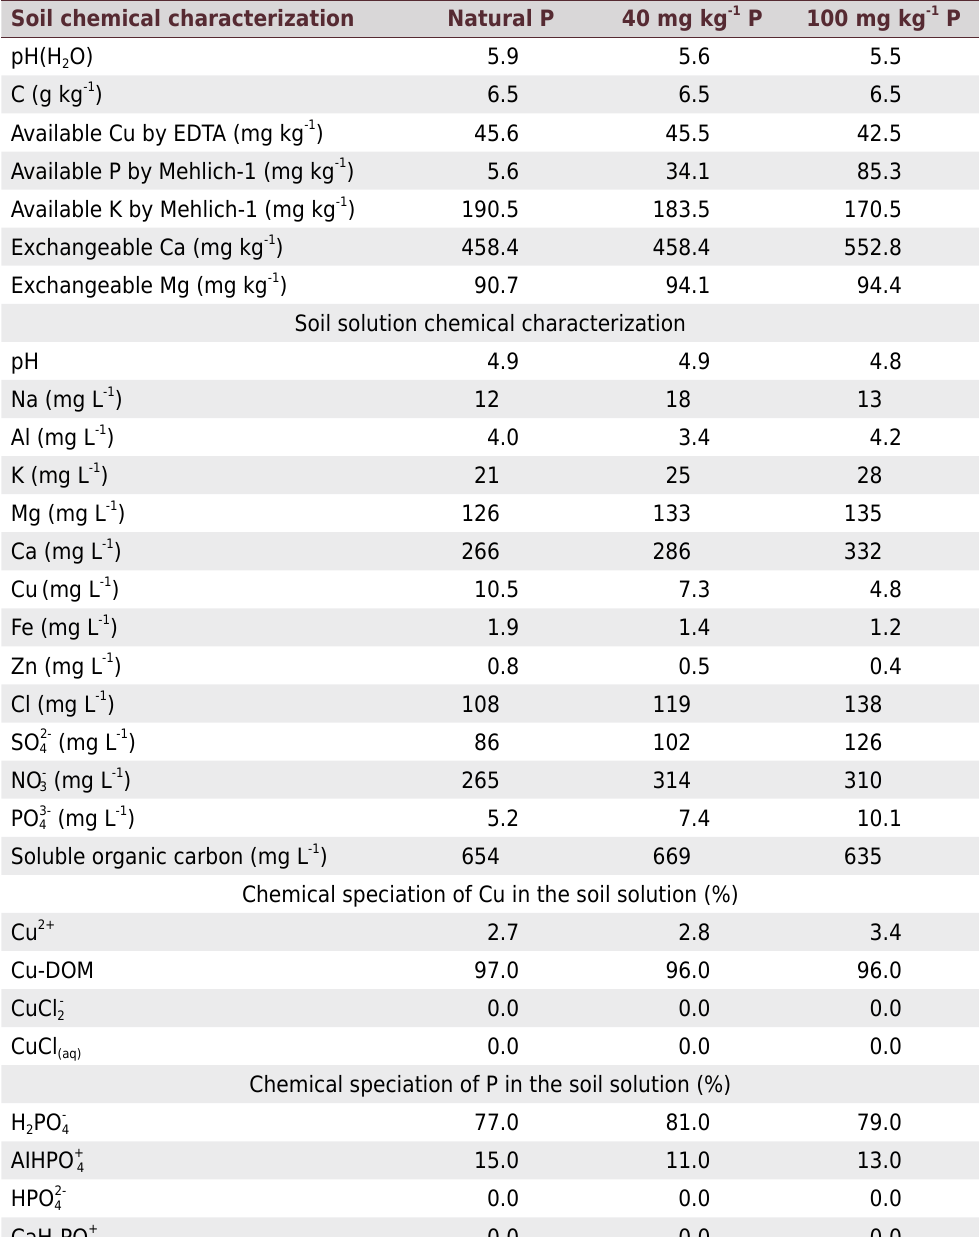
Table 1. Chemical properties of the soil, soil solution, and ionic speciation after treatment with P and Cu Soil chemical characterization